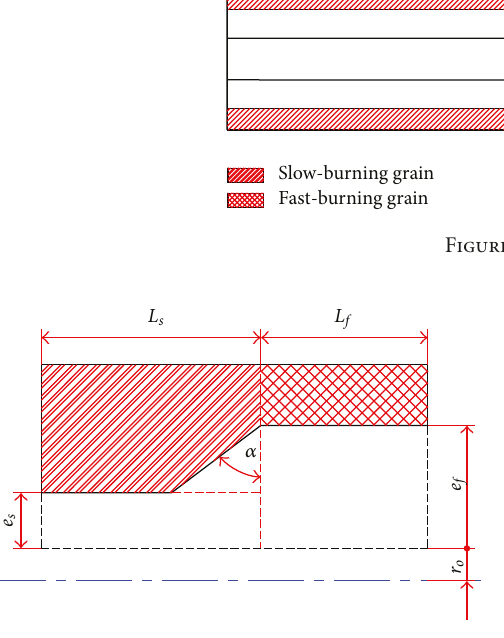
Figure 9: Burnt nonuniform tube grain.